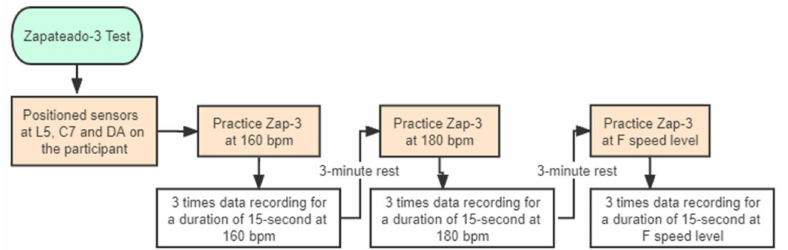
Figure 2. The procedure for the footwork test. L5: the 5th lumbar vertebra; C7: the 7th cervical vertebra; D: the dominant ankle; bpm: beats per minute; F: the fastest speed